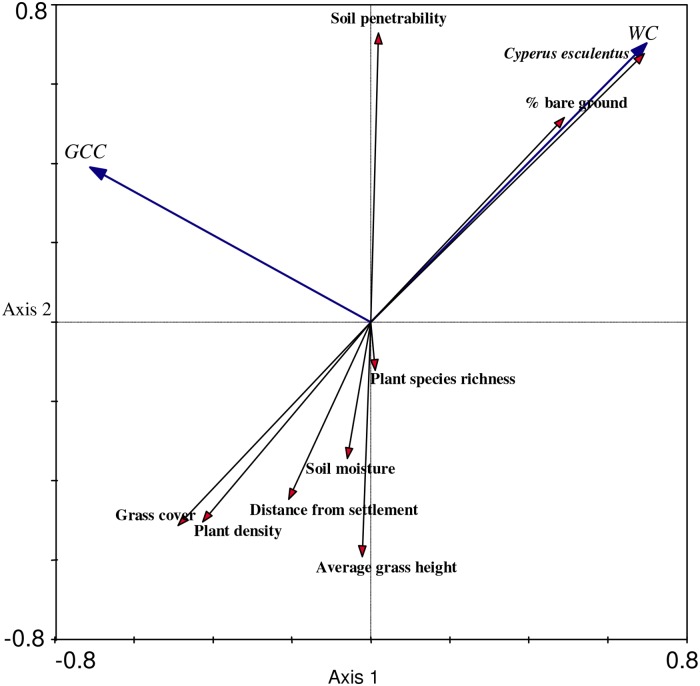
Redundancy Analyses diagram displaying the first two ordination axes on the influence of environmental habitat variables on crane species abundance.Note: WC = Wattled Crane and GCC = Grey Crowned Crane.